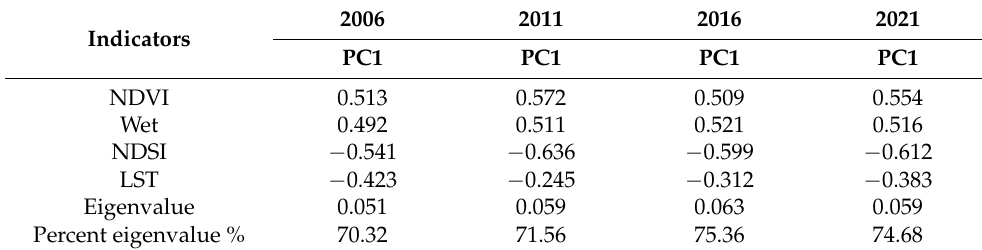
Table 6. Principal component analysis of indicators from 2006 to